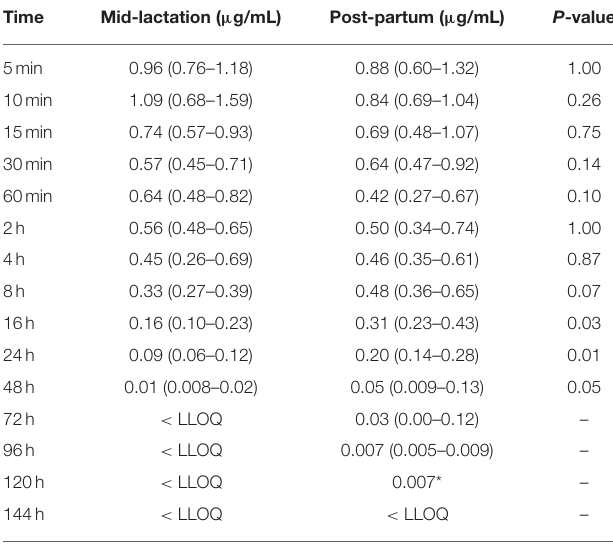
TABLE 2 | Plasma concentrations ( µ g/mL) for meloxicam from seven post-partum cows compared to five mid-lactation cows that received intravenous administration of a single dose of meloxicam at 0.2 mg/kg.